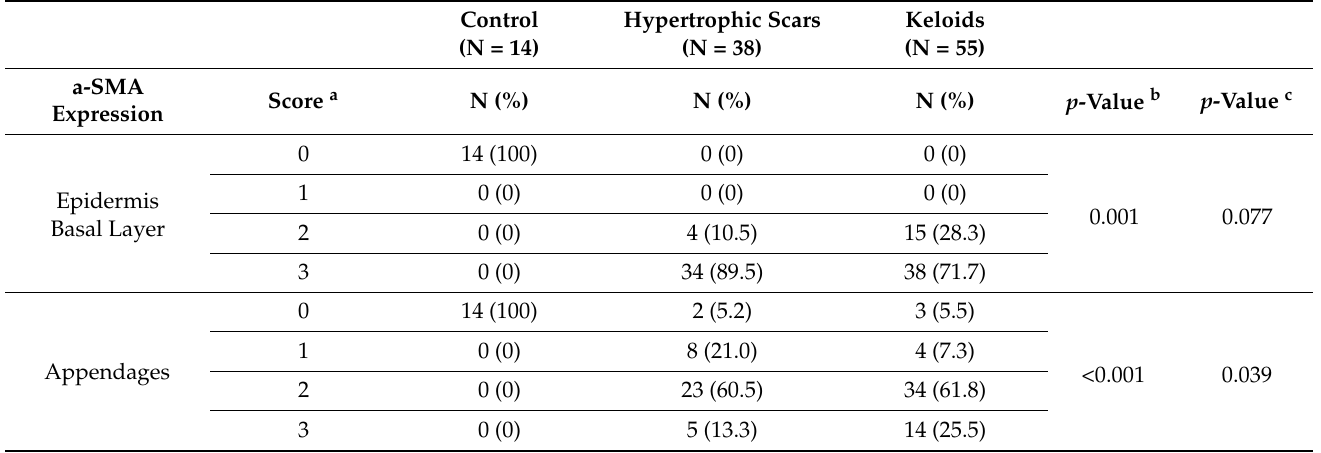
Figure 2. ILK and a-SMA are overexpressed in hypertrophic scars and keloids. Representative cases of control skin ( upper panel ), hypertrophic scars ( middle panel ) and keloids ( lower panel ) show stronger immunopositivity for ILK and a-SMA in keloids compared to scars (magnification 40 × ). Scale bar at 20 µ m (ImageJfiji software). Table 5. Immunohistochemical analysis of a-SMA expression in control skin, hypertrophic scars and keloids.